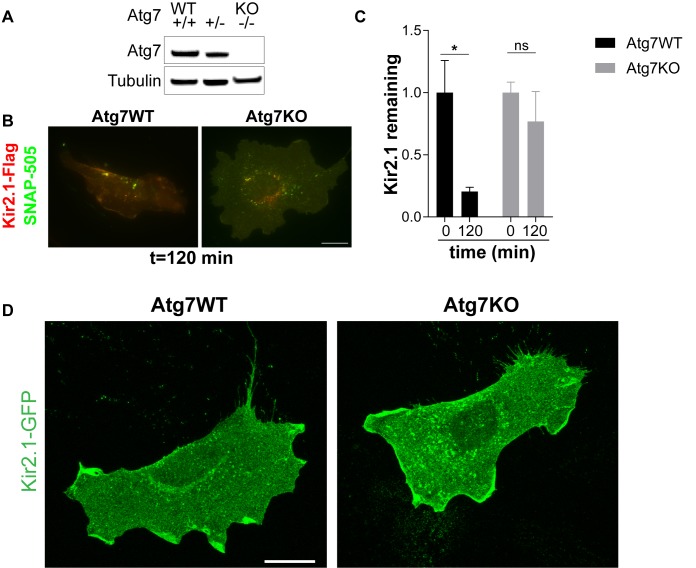
Kir2.1 degradation is disrupted in Atg7KO MEFs.(A) Representative western blot showing the absence of Atg7 in Atg7KO primary MEFs. (B) Representative images of primary MEFs transfected with Kir2.1-Flag-SNAP and labeled with SNAPcell ligand. (C) Snap-labeled Kir2.1 is significantly reduced in Atg7WT cells but not Atg7KO cells. N: (0,120 min) WT: (7,6), KO: (7,6). Data analyzed by two-way ANOVA. Genotype x time: F(1,22)=2.323, p = 0.1417; Genotype: F(1,22)=2.323, p = 0.1417. Time: F(1,22)=7.675, p = 0.0112. (D) The distribution of Kir2.1 is not different between Atg7WT and Atg7KO cells. Data are combined from two independent replicates. *p<0.05.Figure 5—figure supplement 3—source data 1.Source Data for Figure 5—figure supplement 3A.